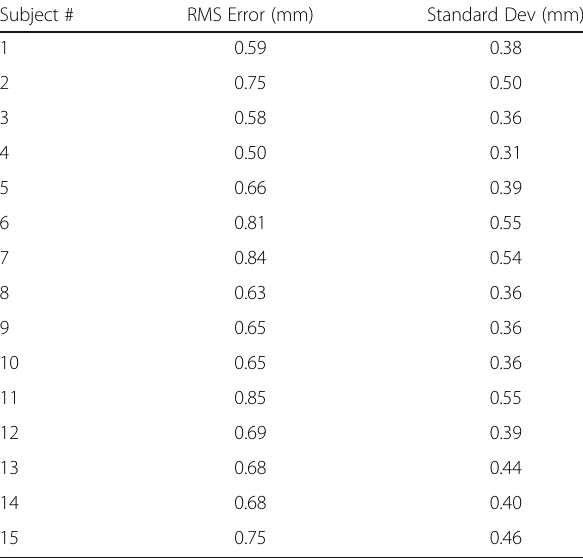
[Table 1 measurements within the registration region of interest represent 15 patients.]